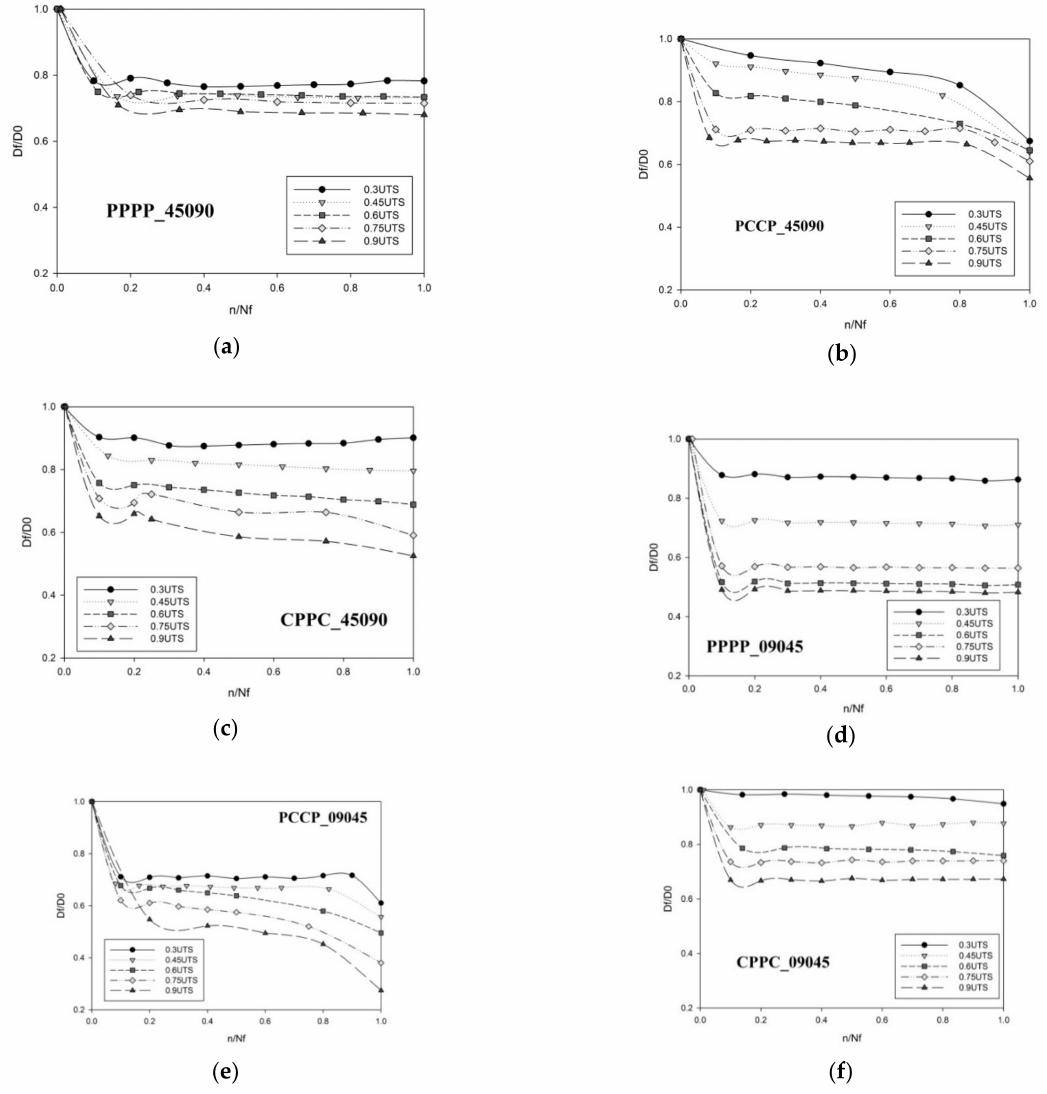
Figure 7. Dynamic modulus of the laminates produced in this study; ( a ) PPPP_45090, ( b ) PCCP_45090, ( c ) CPPC_45090, ( d ) PPPP_09045, ( e ) PCCP_09045 and ( f ).